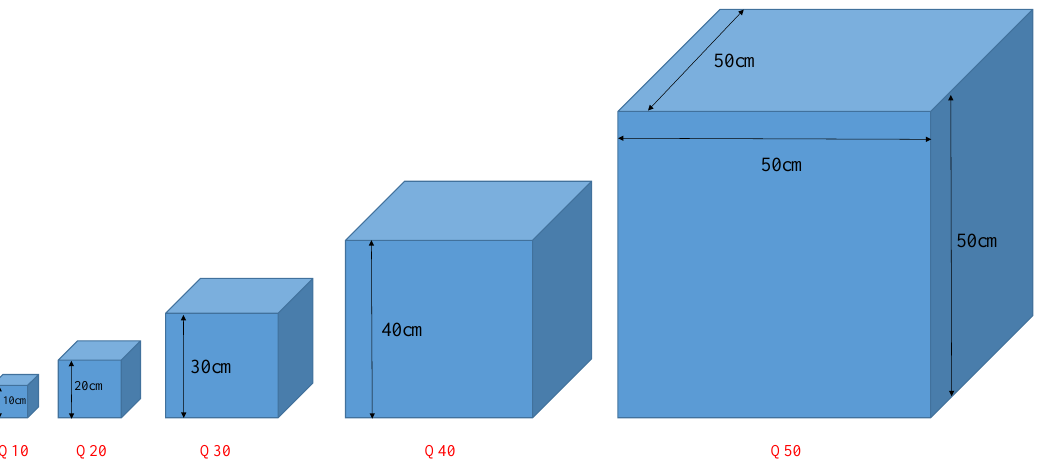
Figure 3. Schematic diagram of the specimens’ dimensions (reinforced by different length of CF and CNT, separately).